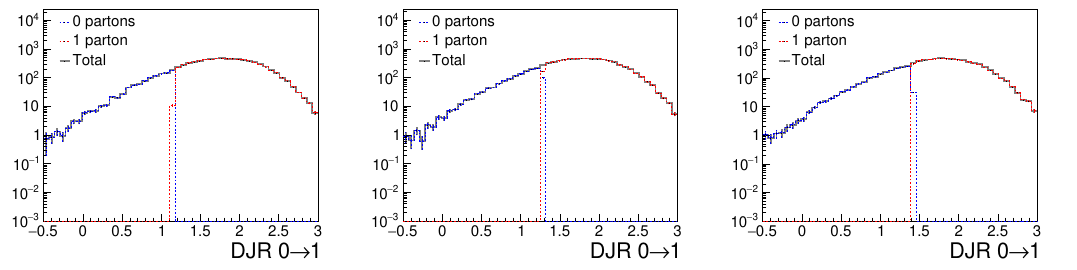
Figure 5 . t¯th DJR plots for xqcut = 10 , qCut = 15 (left), 19 (middle) and 25 (right). Here all Wilson coefficients are set to non-SM values. The x axis and the lines in the plots are the same as described in figure 4.